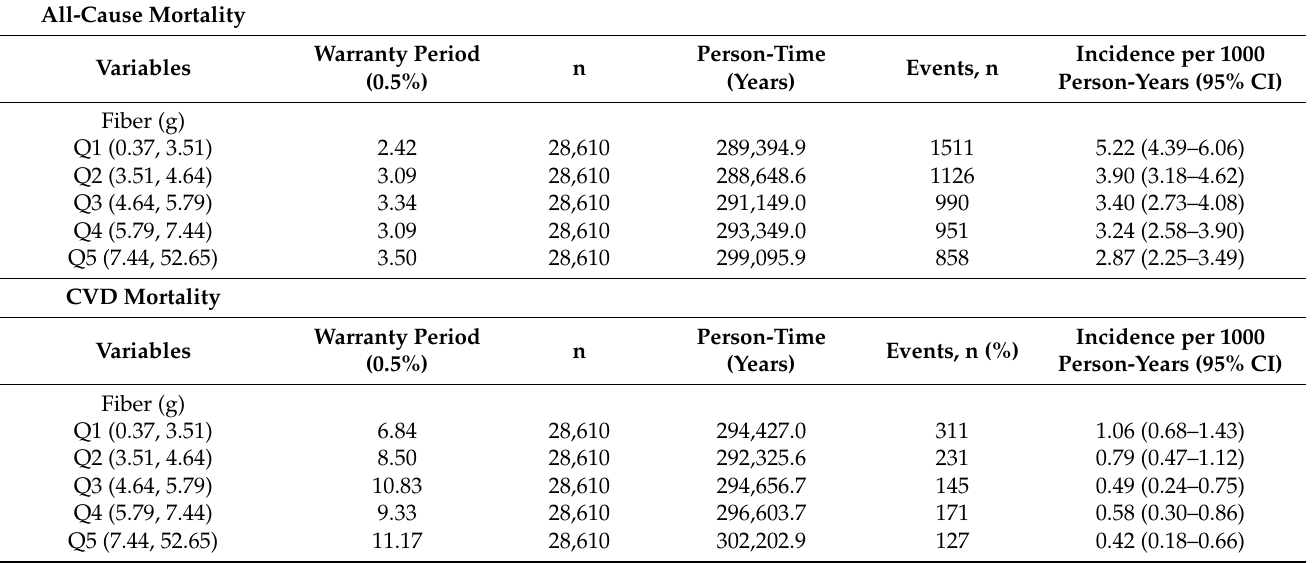
Table 2. Warranty periods for mortality according to fiber intake